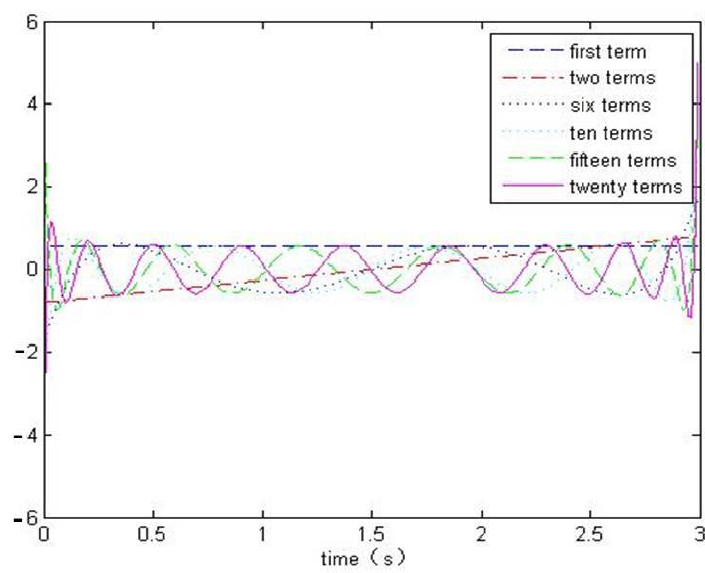
Figure 1. Re-construction of single frequency signals with Chebyshev polynomial.